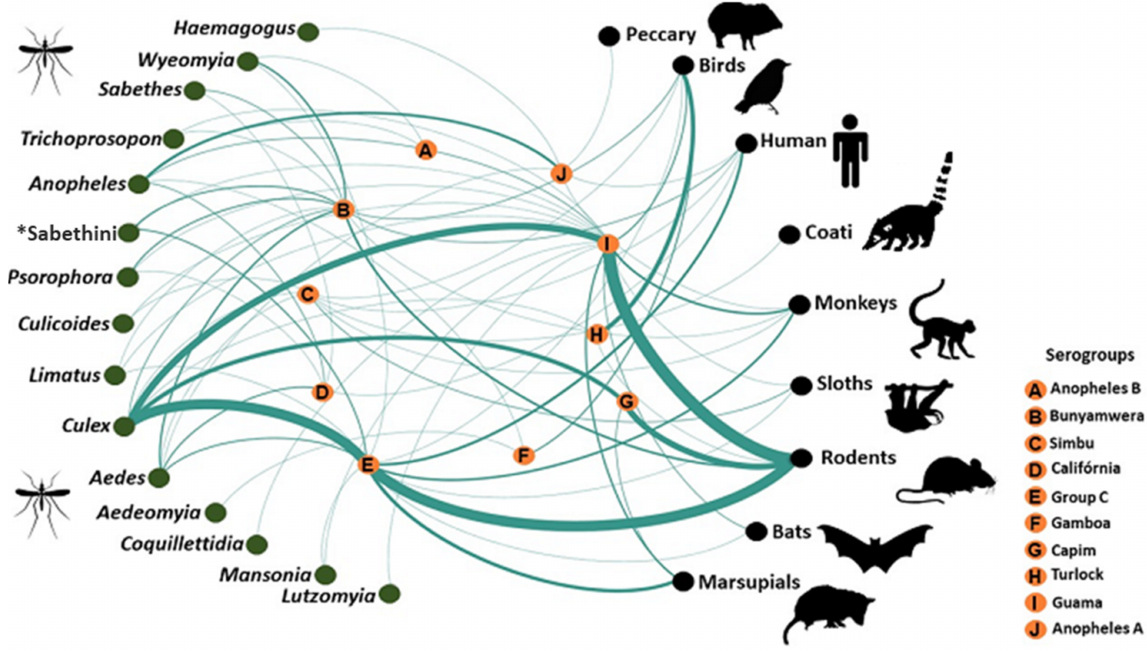
Figure 1. Network of orthobunyaviruses isolated in Brazil by serogroups, hosts and vectors. Lines and their thickness represent number of hosts shared between viruses. Each green dot (left side) represents vector genera; the black dots (right side) represent vertebrate host groups; in the center